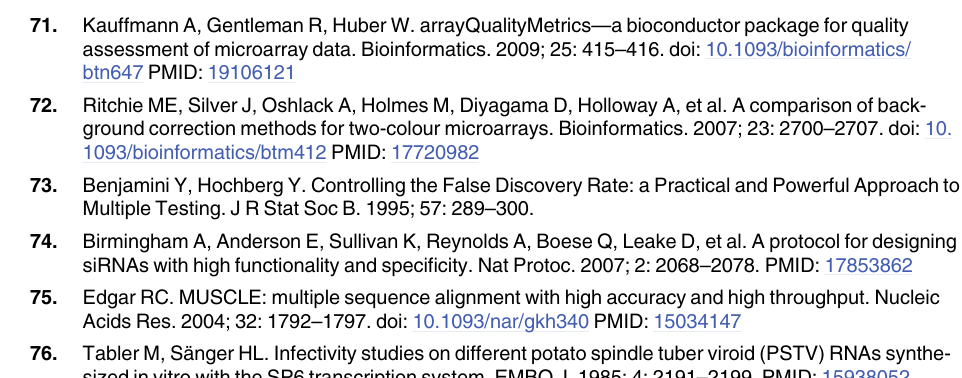
76. Tabler M, Sa¨nger HL. Infectivity studies on different potato spindle tuber viroid (PSTV) RNAs synthe- sized in vitro with the SP6 transcription system. EMBO J. 1985; 4: 2191–2199.